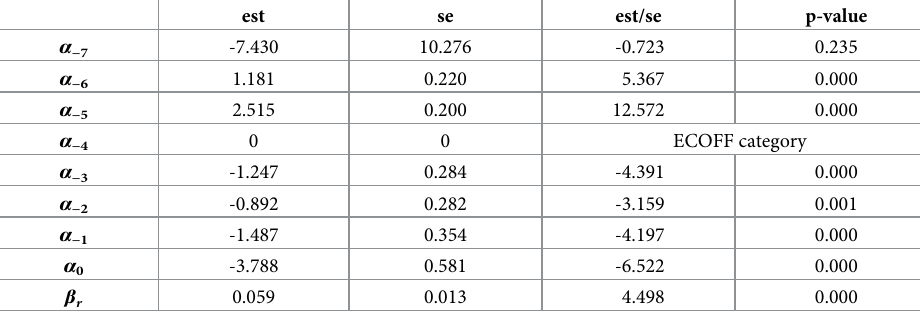
Table 4. The CIPR data. Model 7: estimate, standard error, t-value and p-value. est